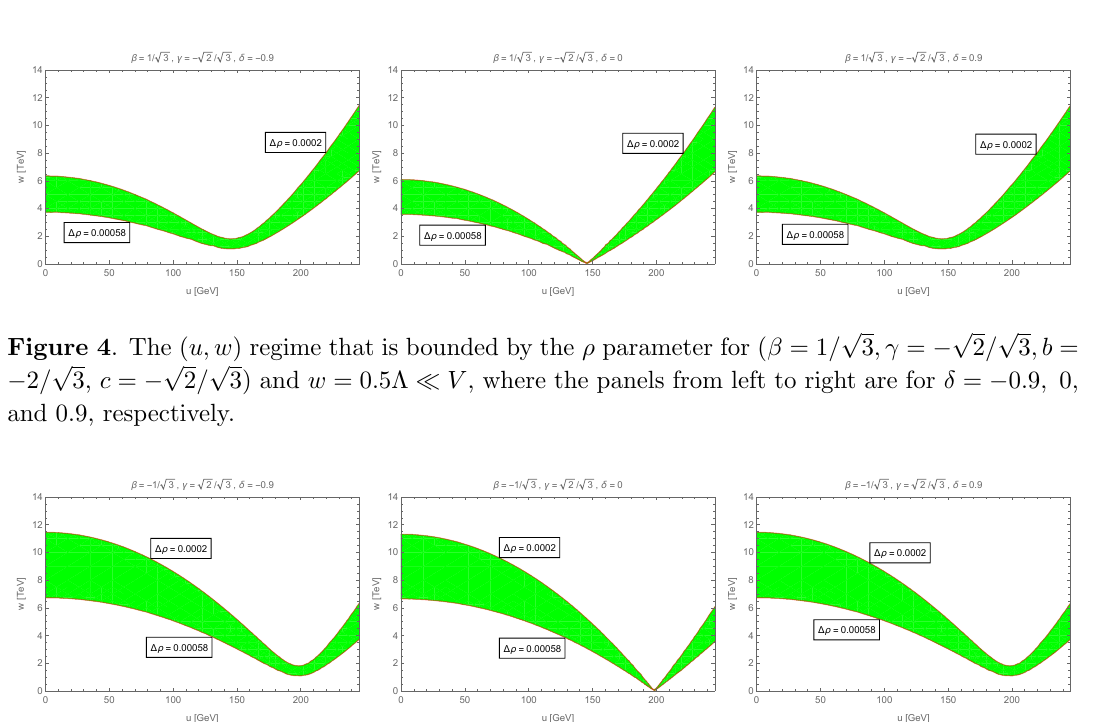
1 / √ 3 , γ = √ 2 / √ 3 , b = − 0 . 9 , 0, −